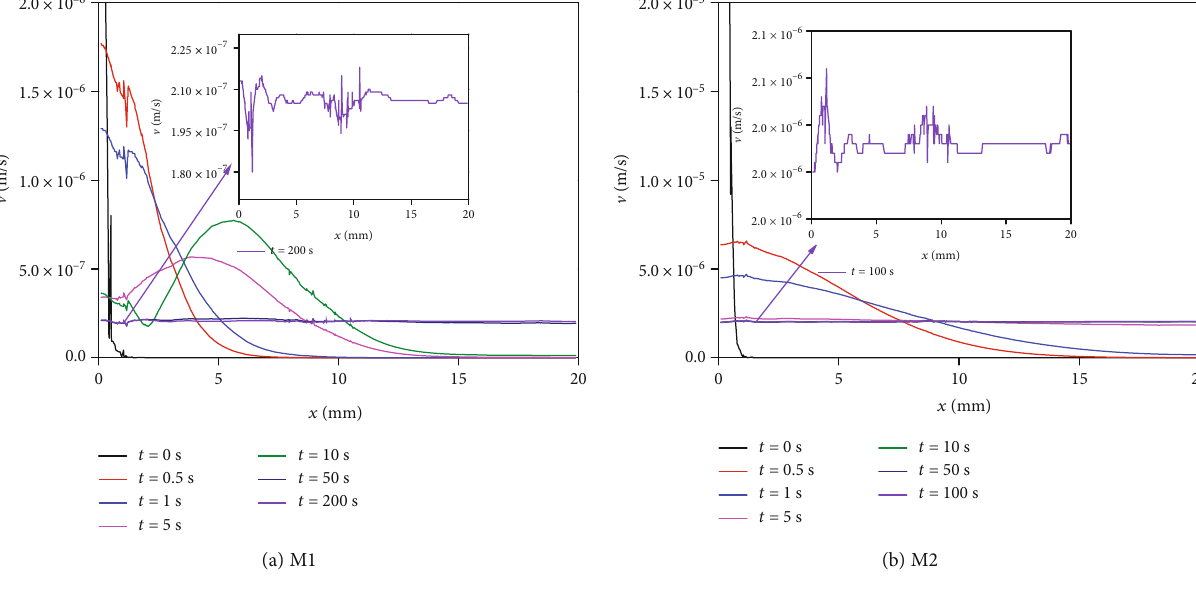
Figure 15: Variations in Darcy ’ s velocity along the fracture length. Table 4: Volume fl ow rate through the matrix and fracture under di ff erent inlet water